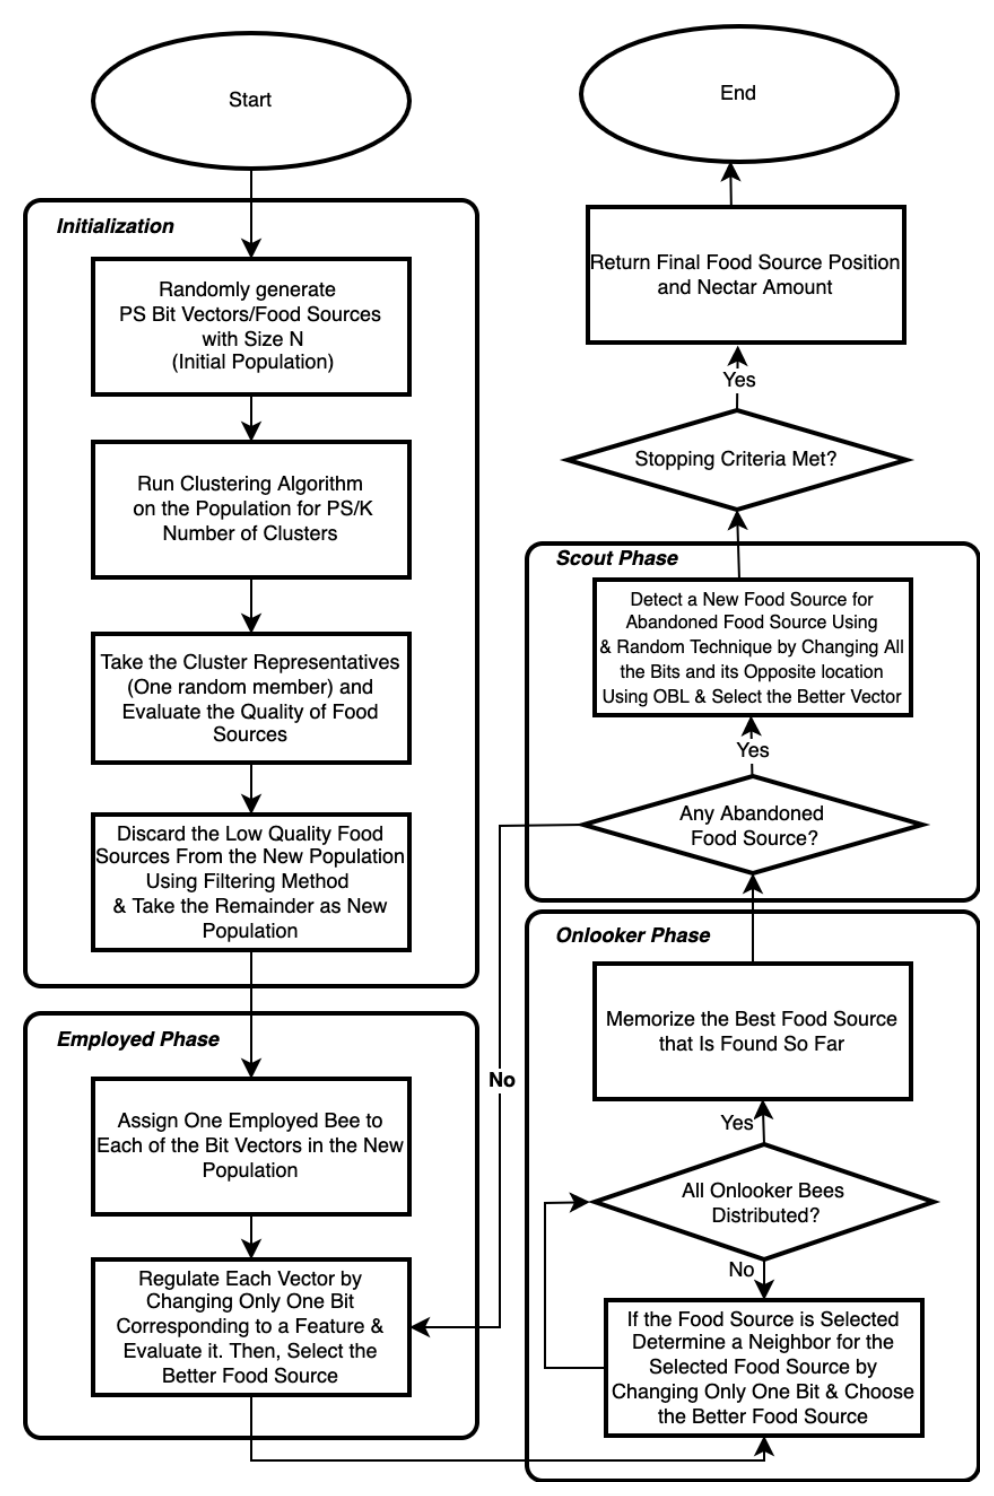
Figure 2. The flowchart of the proposed A2BCF algorithm (stopping criterion could be set to the maximum of number of evaluations or